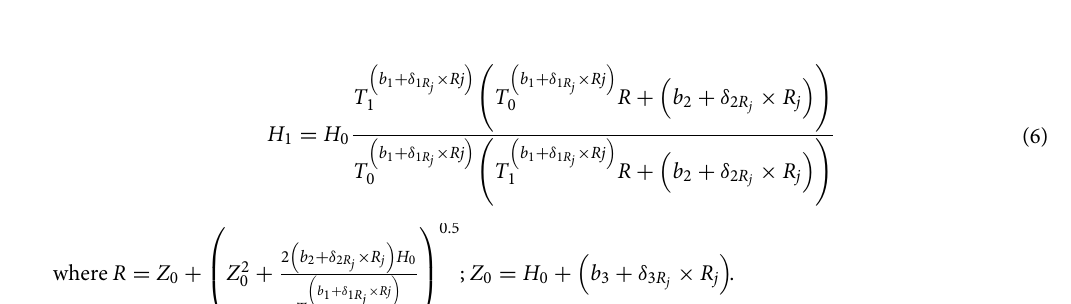
Table 6. Parameters of the regional model developed using a nonlinear fixed-effects modelling approach. Expansion terms (δ iRj ) expressing the difference in the values of ith parameters (b i , i = 1, 2, 3) of the Eq. (5) in jth regions (Rj, j = 1, 2, … 6).